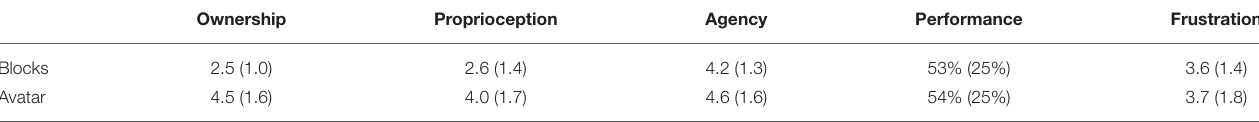
TABLE 2 | Mean values and (standard deviation) per